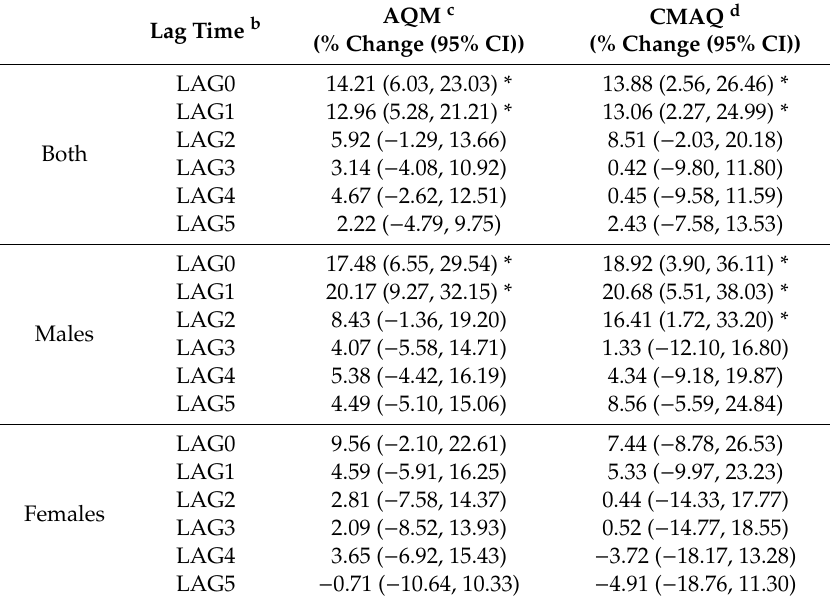
Table 4. The lag e ff ects of AQM- and CMAQ-NO 2 on AD symptoms (0–3 km) a .